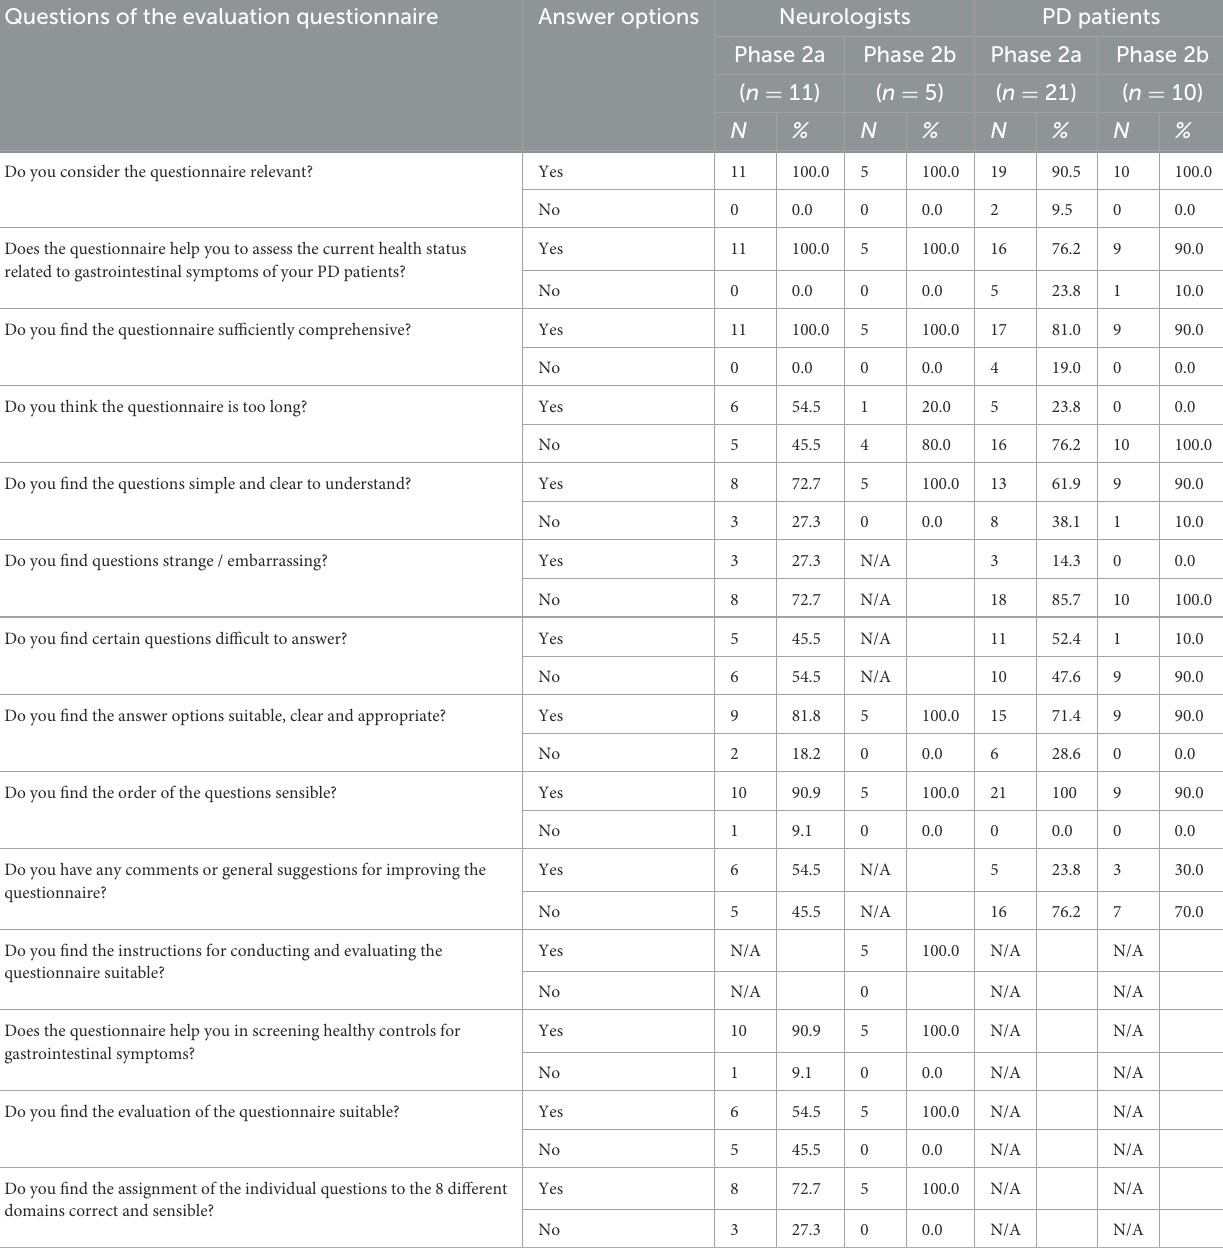
TABLE 5 Results of the evaluation questionnaire for neurologists and patients with Parkinson’s disease of the phase 2a and 2b study. Questions of the evaluation